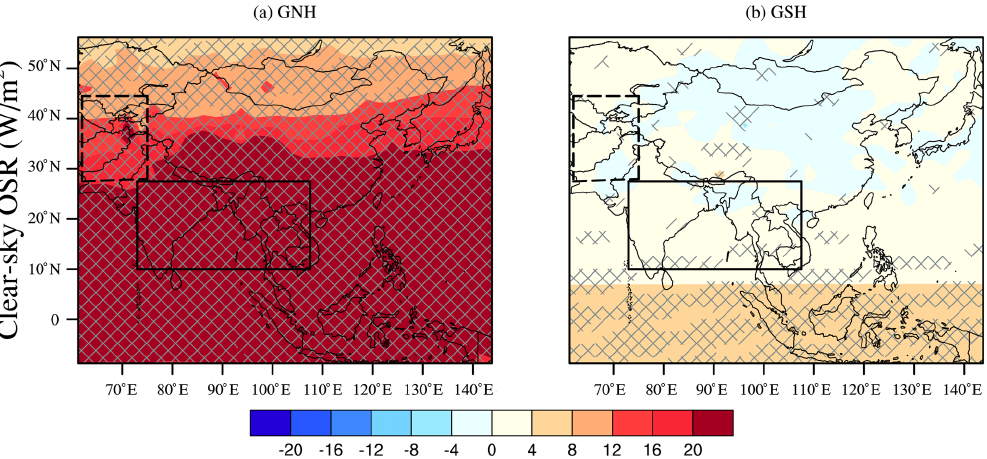
Figure 9. Spatial distribution of top-of-the-atmosphere outgoing shortwave radiation (TOA OSR; Wm − 2 ) anomalies under clear-sky con- ditions in the eruption year with respect to the mean of 5 years before the eruption. The solid and dashed black boxes indicate the relatively wettest area (RWA) and the relatively driest area (RDA), respectively, as shown in Fig. 1. The gray slashes and cross signs indicate the significant results at the 95% and 99% confidence